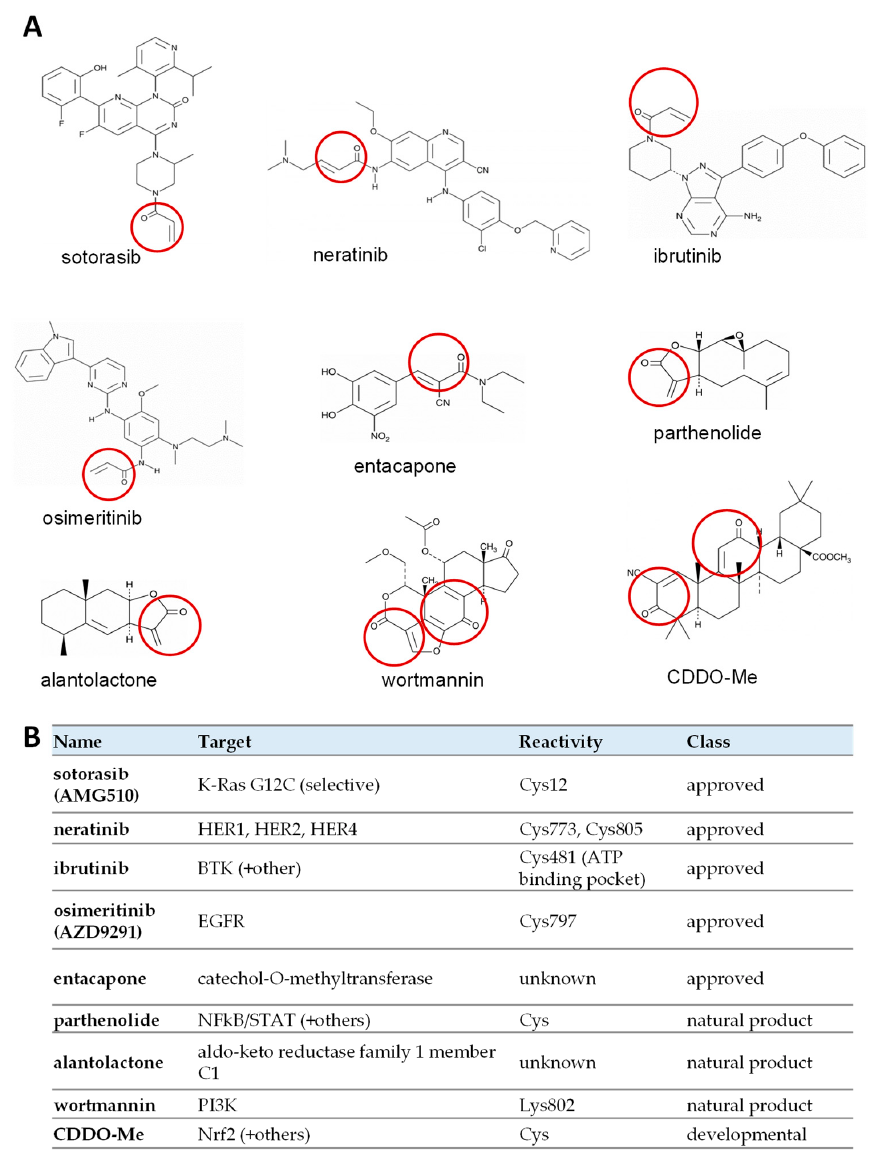
Figure 6. Chemical structures and properties of currently available clinically relevant warheads. ( A ) Chemical structures of several warheads commercially available. Red circles identify functionally active α -, β -unsaturated carbonyl groups. CDDO-Me = 2-cyano-3,12-dioxooleana-1,9(11)-dien-28-oic acid methyl ester. ( B ) Overview of primary biological targets, the known targeted amino acids and drug classes (admission status). Sources: sotorasib [68], neratinib [58,69], ibrutinib [70], osimeritinib [71], entacapone [72], parthenolide [58,73], alantolactone [58,74], wortmannin [58,75], CDDO-Me